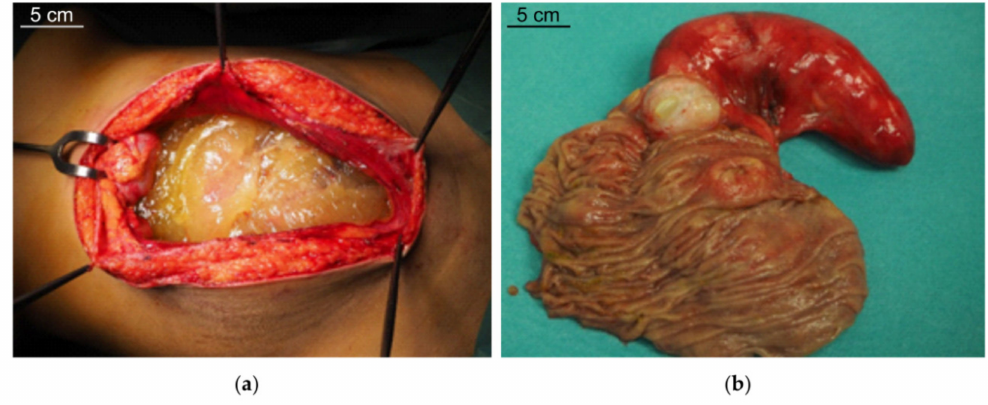
Figure 1. ( a ) Intraoperative view of abdominal mucin accumulation in pseudomyxoma peritonei (PMP) and ( b ) appendiceal mucinous neoplasia with mucocele.